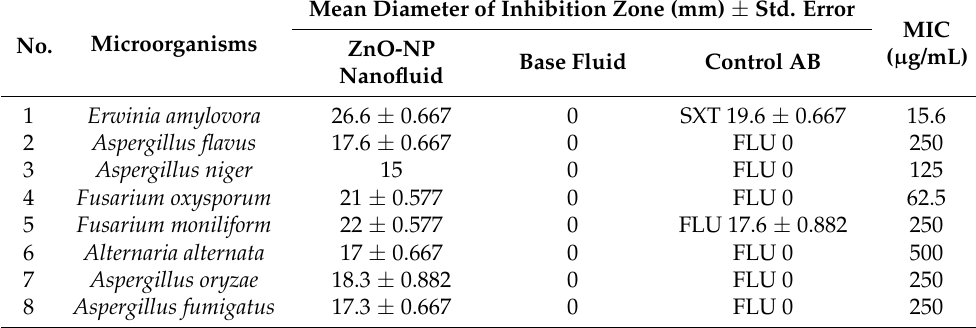
Table 4. Antimicrobial activity and MIC values of biosynthesized ZnO-NPs.